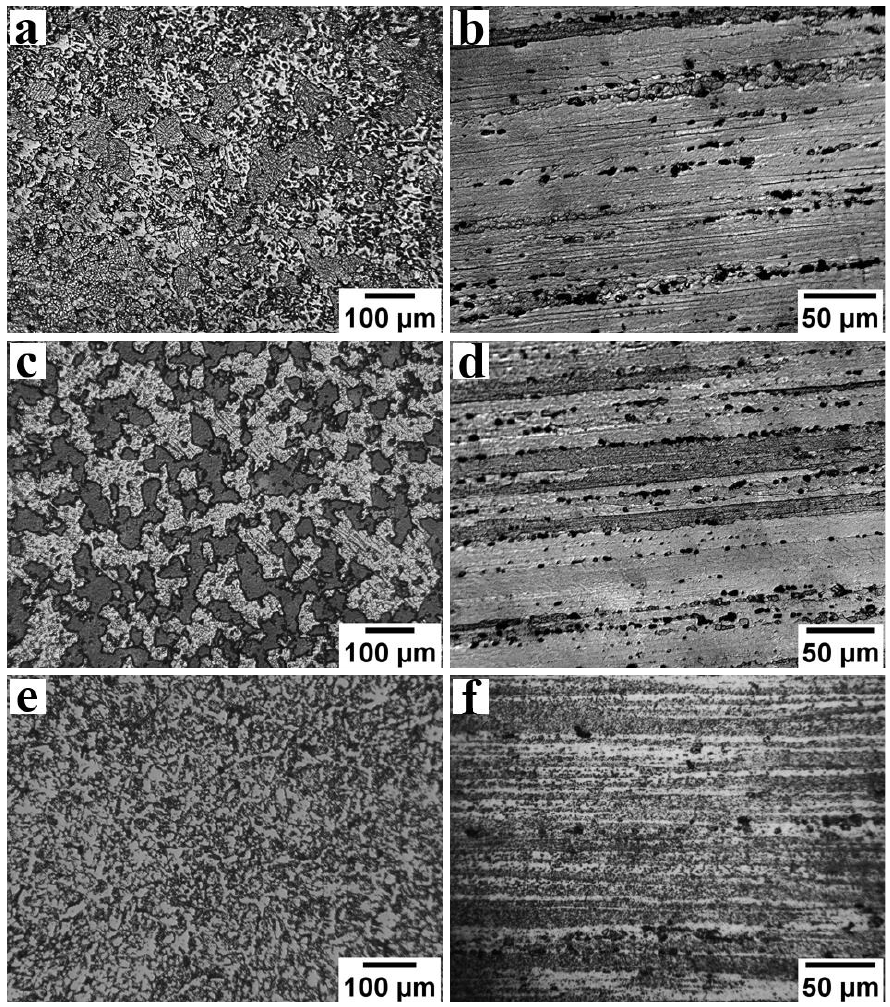
Figure 3. Optical micrographs along the transverse and longitudinal to the axis of the base alloy rods in AA7075-STA ( a , b ), AA7075-ST ( c , d ), and AA5083 ( e , f ).